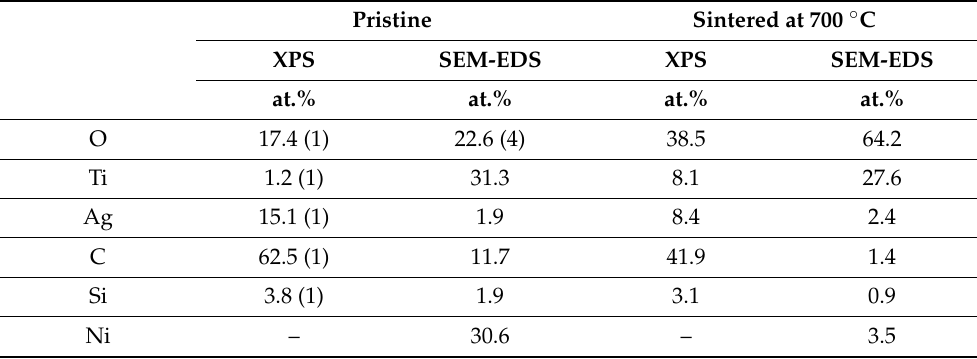
Table 1. Atomic percentage concentration of the individual elements of the coat-forming materi- als. Data originated from the modified NiTi alloy before and after sintering at 700 °C per 2 h. The SEM-EDS should be considered to be a semi-qualitative method in this analysis. The data in brack- ets refers to the standard deviation data, which was obtained based on the measurements of the five different points.